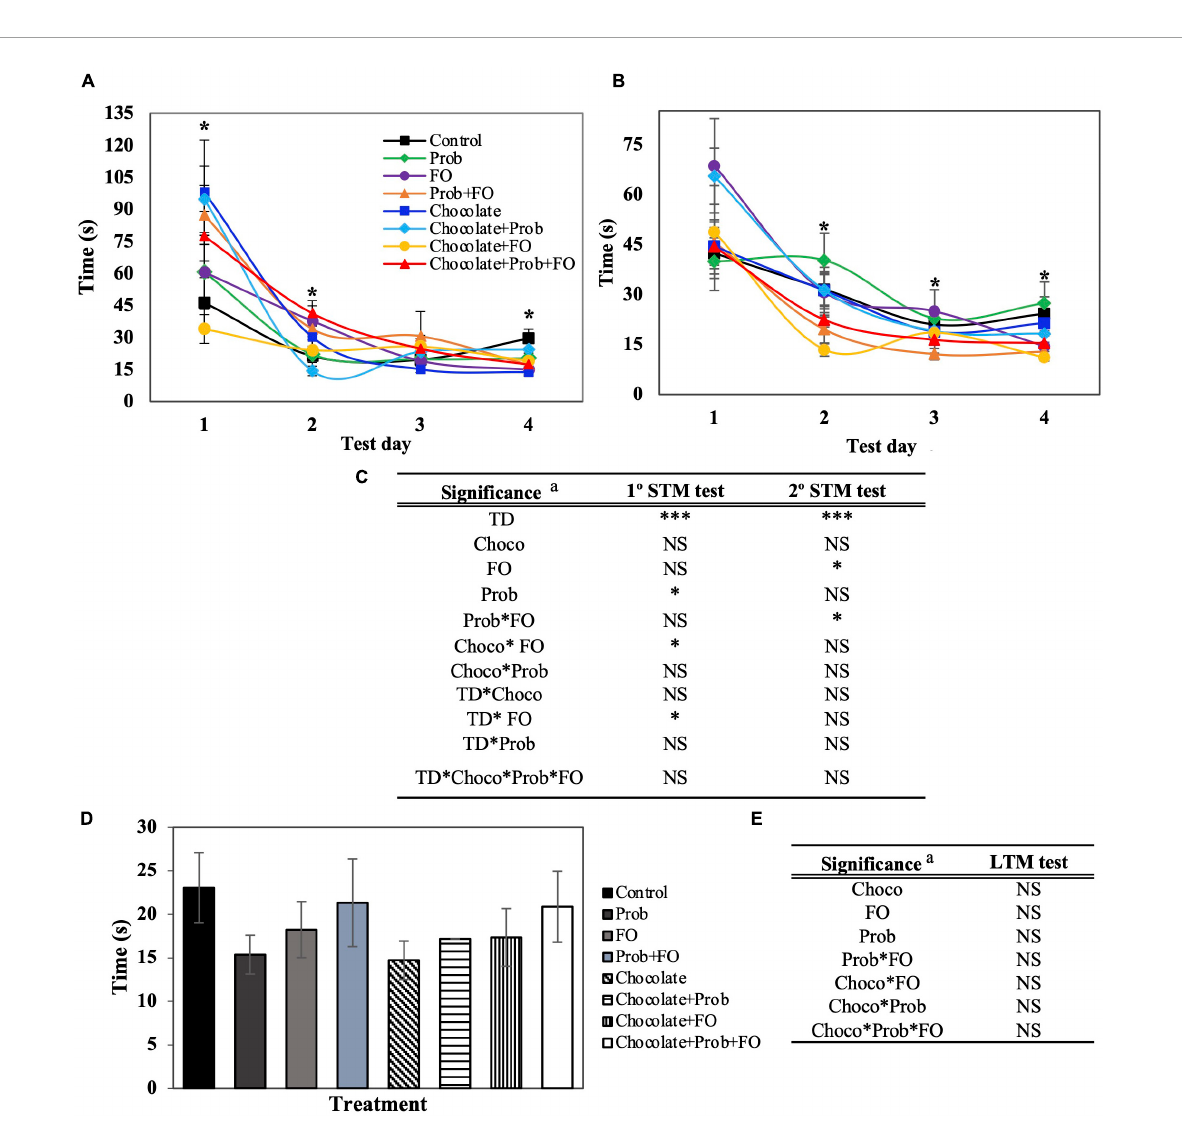
FIGURE2 Total latency of rats using Barnes Maze test. STM, short-term memory; LTM, long-term memory; TD, test days; Choco, chocolate; FO, fish oil; Prob, probiotics; NS, non-significant. a Asterisks (*) indicate significant difference LSD test: * p < 0.05, *** p < 0.001. (A) First session of STM test, (B) Second session of STM test (after 45 min), (C) Significance of treatments interactions and test days on the first and second STM test, (D) LTM test (7th day), (E) Significance of treatments interactions and test days on the LTM test. Values are means ( n = 8), and bars indicate the standard error of the